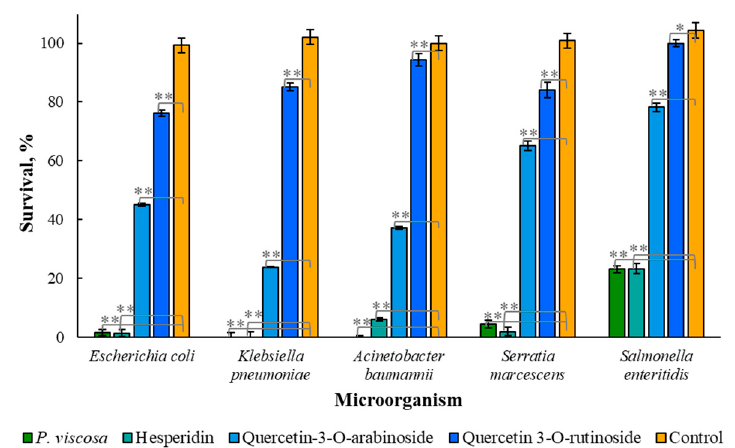
Figure 3. Effect of P. viscosa crude extract and its phytochemicals on the eradication of drug-resistant microorganisms ( Escherichia coli , Klebsiella pneumoniae , Acinetobacter baumannii , Serratia marcescens and Salmonella enteritidis ). The phytochemicals were applied at a concentration of 2 µM. Data from three independent experiments are shown. One asterisk designates data of no significant difference, and two asterisks show data of statistically proven difference ( p < 0.001).